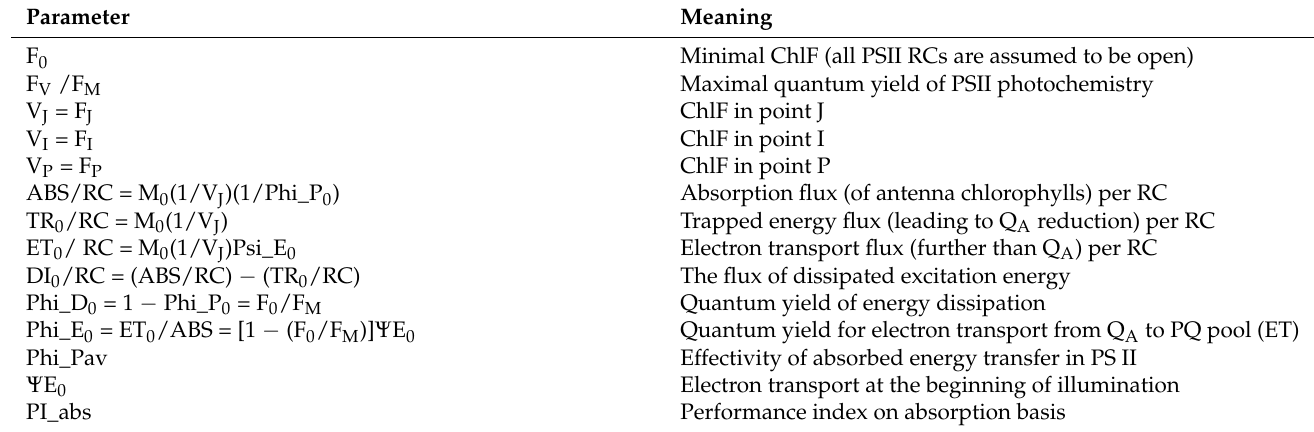
Table 1. Overview and characteristics of the chlorophyll fluorescence parameters derived from the fast chlorophyll fluorescence kinetics (OJIP). Adopted from Stirbet et al. [26].